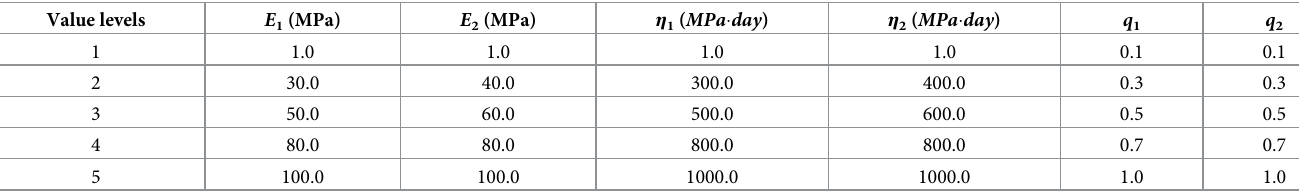
Table 7. Parameter level of the fractional differential constitutive model on soft soil. Value levels